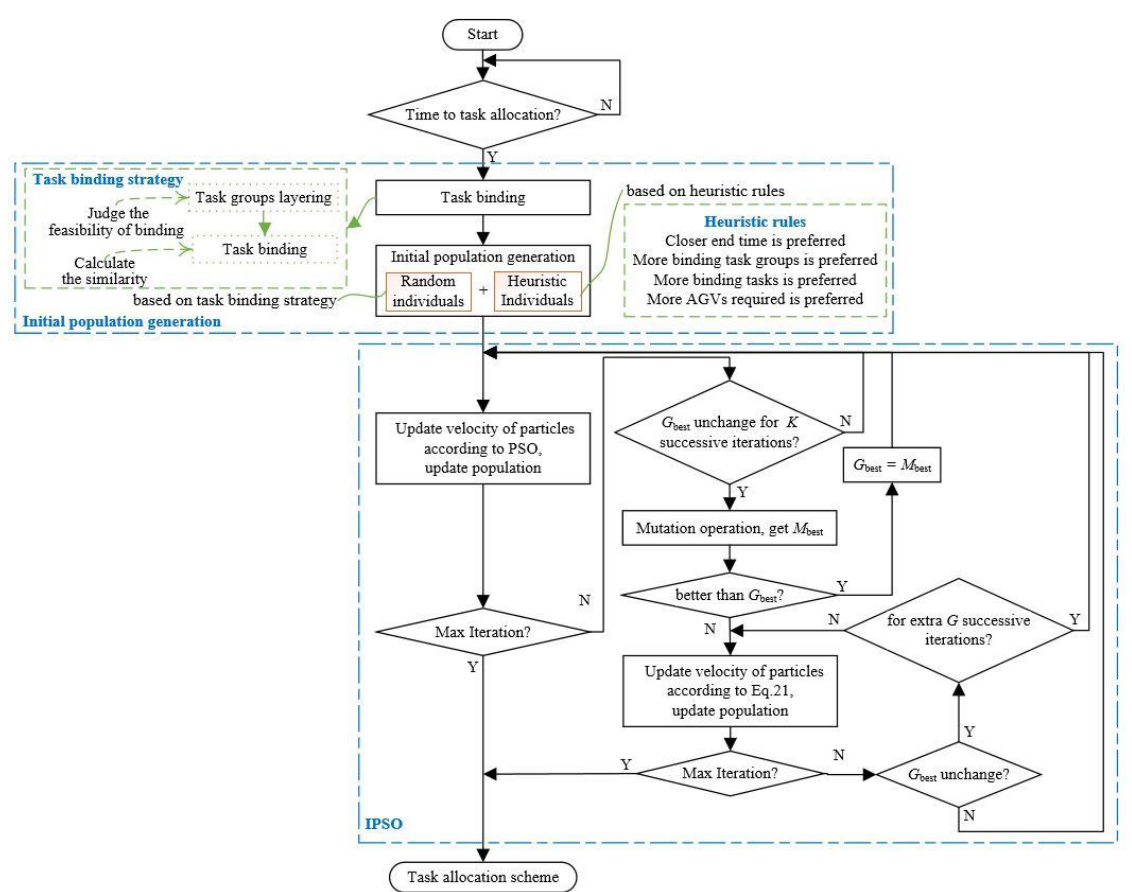
Figure 2. The flow chart of the hybrid task allocation method based on task binding strategy and IPSO.